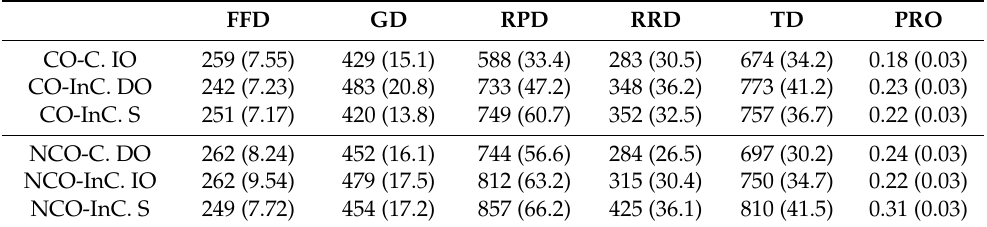
Table 4. Mean Values for the Six Conditions (in msec. for durations), with Standard Errors in Parentheses, for the Six Eye-tracking Measures at the Replacive Phrase